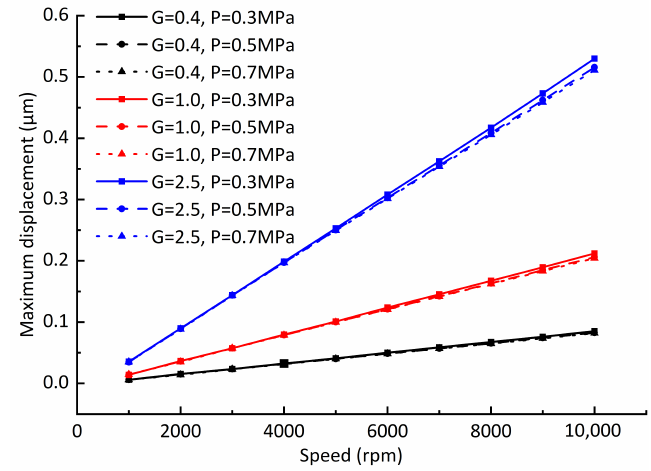
Figure 16. Influence of rotating speed on rotor dynamic equilibrium position offset.